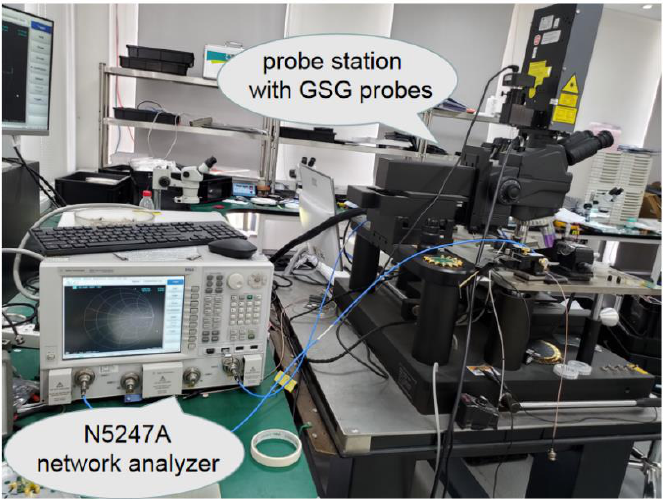
Figure 4. Test environment of reflectionless band-pass filter. The network analyzer and probe station with GSG probes are pictured.